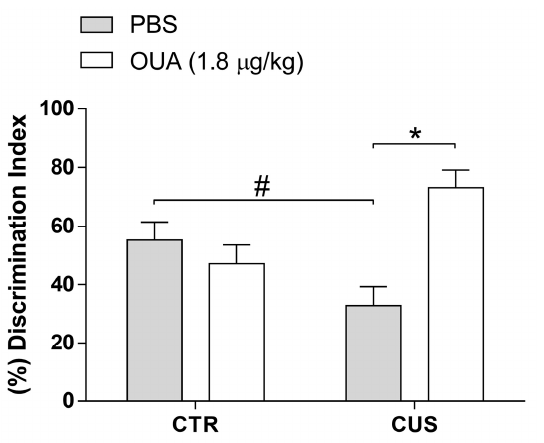
Figure 7. Ouabain (OUA) prevents chronic-unpredictable-stress-induced memory impairment. After 24 h of the last stressor stimulus, the animals were submitted to the test where they were exposed to two equal objects. After three days, an object was replaced, and the time of exploration of the two objects was quantified to evaluate the long-term memory. Data are represented by the percentage of the discrimination index ( n = 7–9) (F (1, 26) = 0.08254; p = 0.7762 for CUS factor. F (1, 26) = 6.488; p = 0.0171 for treatment factor). Data are presented as mean ± SEM. # p < 0.05 when compared CTR-PBS x CUS, * p < 0.05 when compared with CTR-CUS x CUS-OUA (a two-way ANOVA, followed by Newman–Keuls post hoc test, revealed a significance).